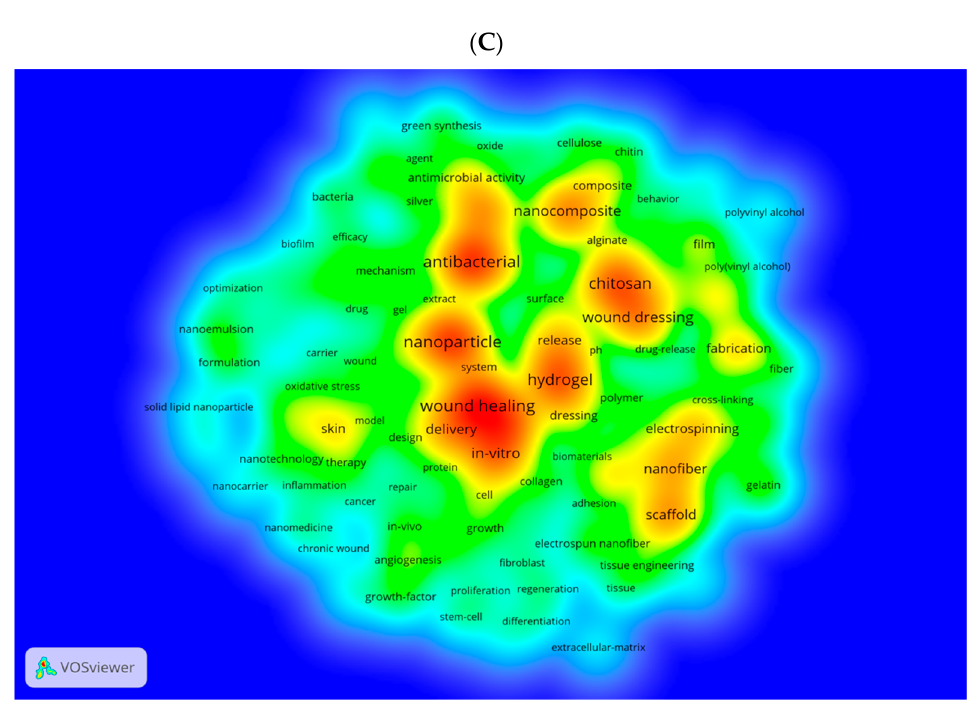
Figure 9. ( A ) The network map of keywords for NDSRSs research in the wound healing field generated by VOSviewer. ( B ) Overlay visualization of keywords generated by VOSviewer. ( C ) The density map of keywords for NDSRSs in the wound healing field was generated by VOSviewer. Clustering analysis was also performed for co-occurrence keywords, as shown in Table 5. The top 20 keywords in terms of frequency for NDSRSs in the wound healing field.